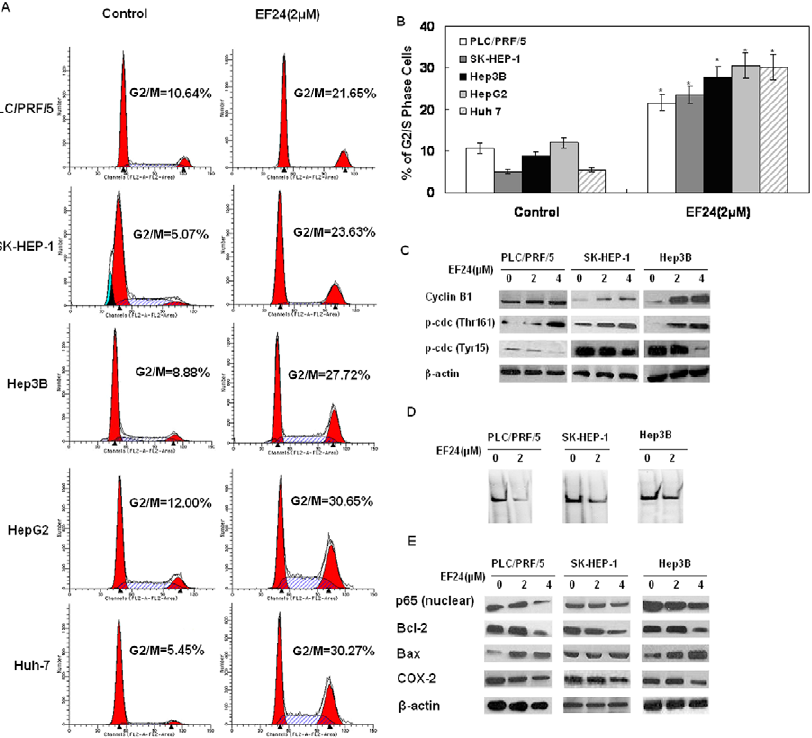
Figure 2. EF24 induced cell cycle arrest and inhibited the NF- k B pathway. ( A ). DNA content (propidium iodide) and cell cycle analysis of EF24-treated cells. The five HCC cells were incubated with 0, 2 m mol/L EF24 for 48 h. The numbers of cells in G0/G1 phase, S phase and G2/M phase was determined via flow cytometry. ( B ). Representative histograms from cytometrically analyzed the five cell lines treated with control and EF24. Assay was done in triplicate and p , 0.05 is denoted by ‘‘*’’. ( C ). Expression of G 2 /M cell cycle relative proteins Tyr15 and Thr161 phosphorylation of cdc2 and Cyclin B1 were determined via western blot after treatment with 2 and 4 m mol/L EF24 for 24 h. b -actin was used as the internal control. ( D ). Nuclear extracts were prepared and subjected to EMSA to measure NF- k B DNA-binding activity. ( E ). Expression of p65, Bcl-2, Bax and COX-2 via western blot.